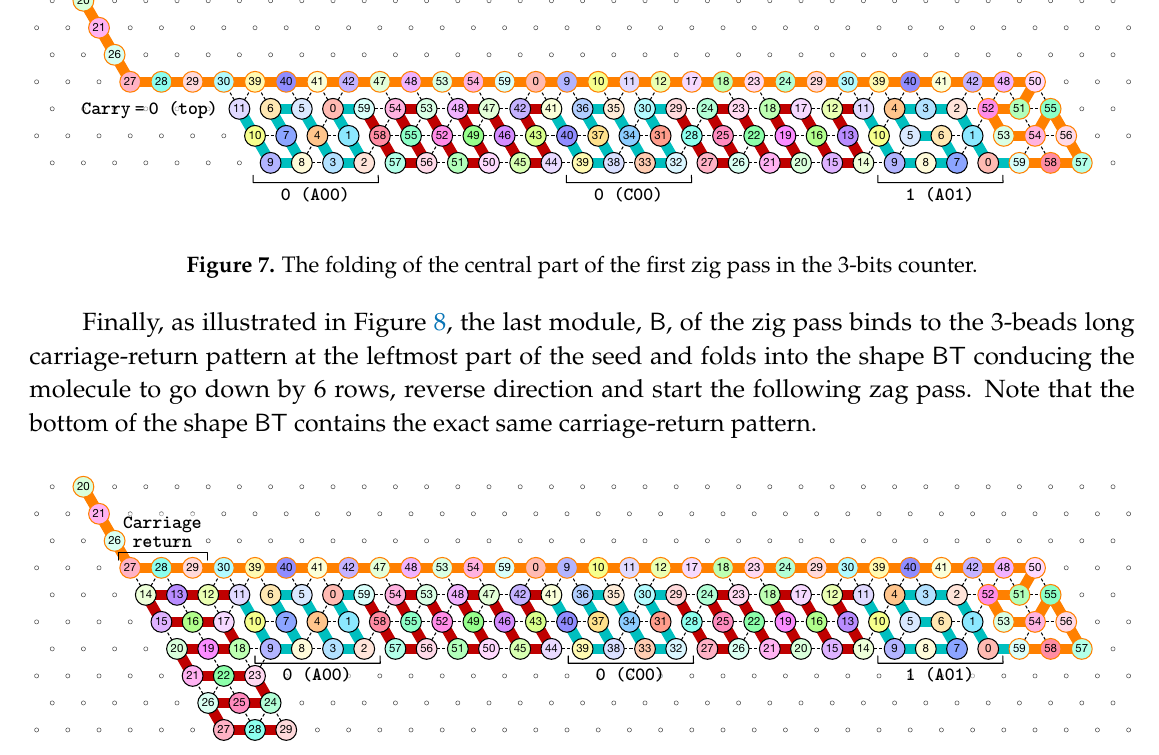
Figure 8. In our construction, the leftmost three beads of any configuration are different from the other beads the left U-turn module binds to inside the zig or zag pass: when the left U-turn module folds next to these bead types, it “triggers” the production of an actual U-turn.